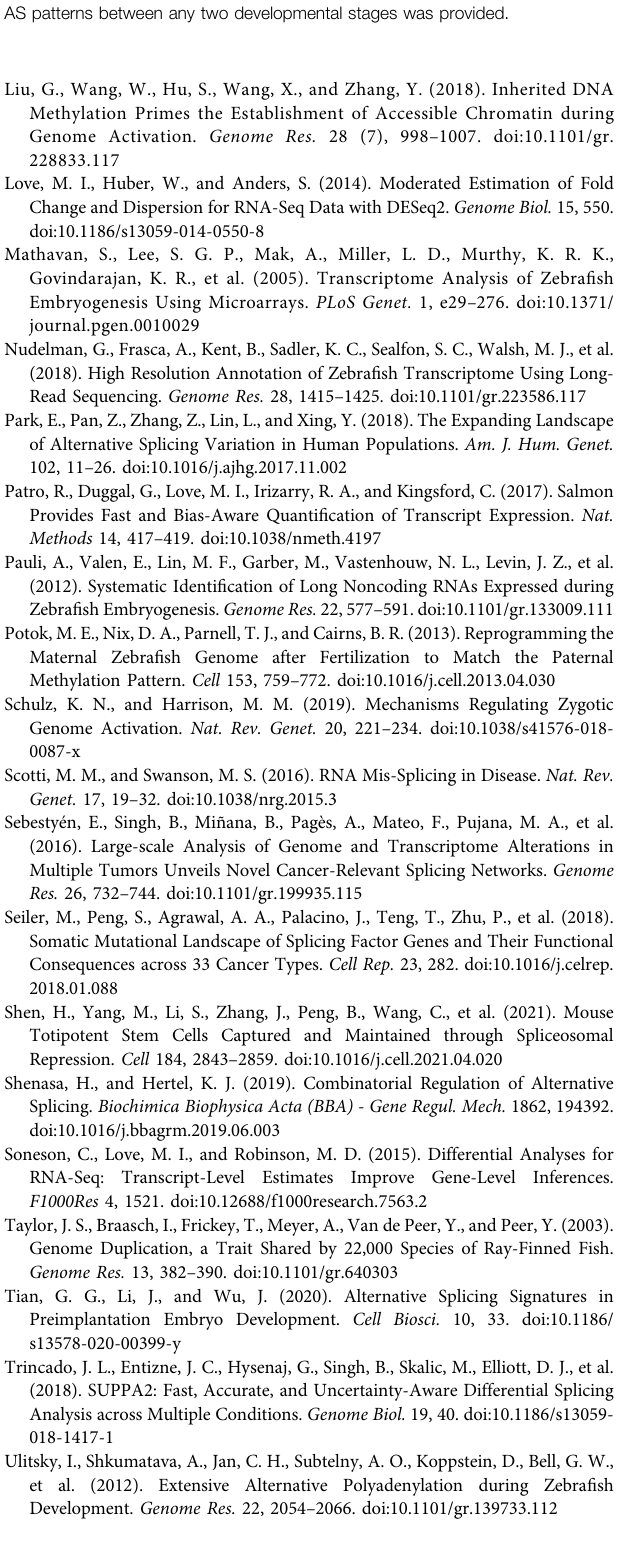
Supplementary Table S3 | The number of DEGs between any two developmental stages.